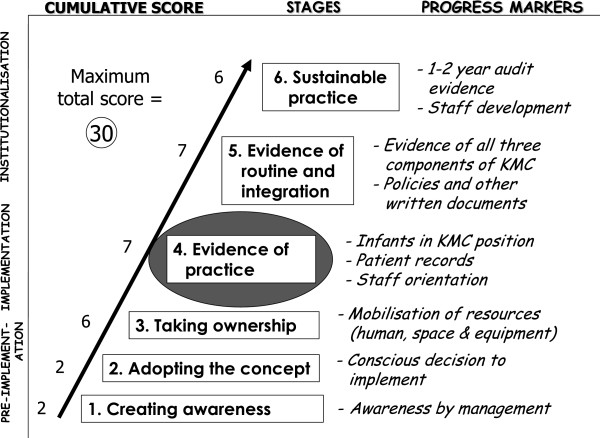
Model for progress monitoring[28].